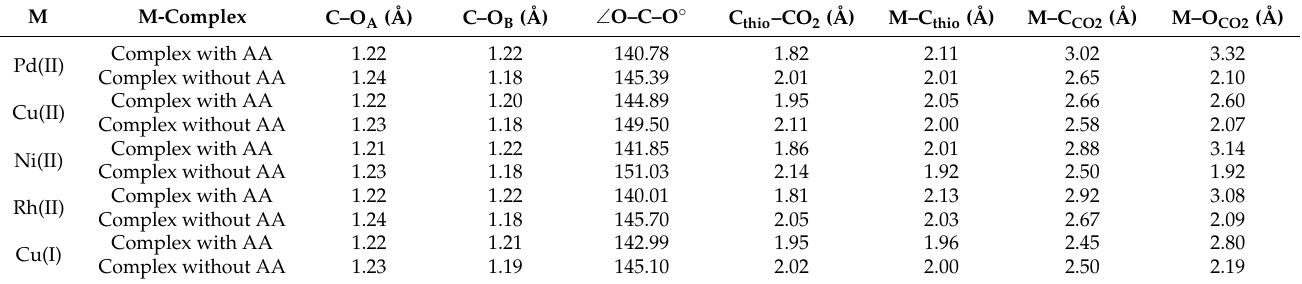
Table 1. The geometry parameters of each transition state structure for different transition